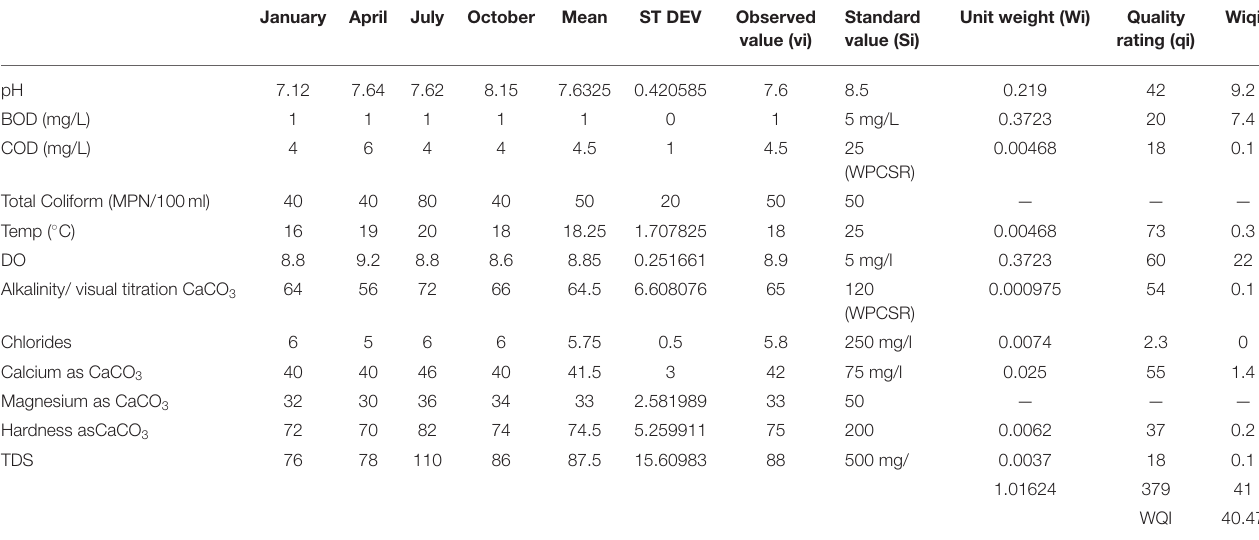
TABLE 3 | Physicochemical parameters and water quality analysis at Dehradun for